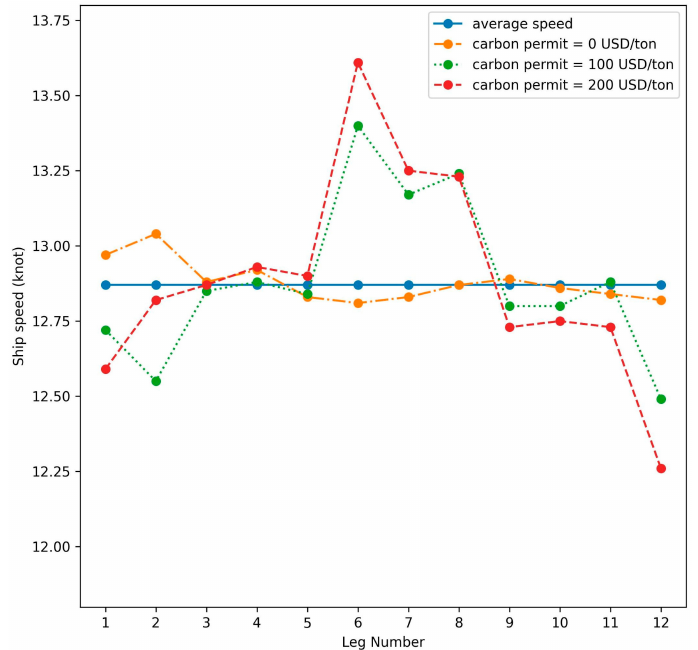
Figure 11. Theoretical average speed (blue solid line), cost minimization optimal speed (orange dashed dotted line, green dotted line, and red dashed line) in all legs represent Scenario 2 and Scenario 4 with a 100 USD carbon permit, and Scenario 4 with a 200 USD carbon permit, respectively.